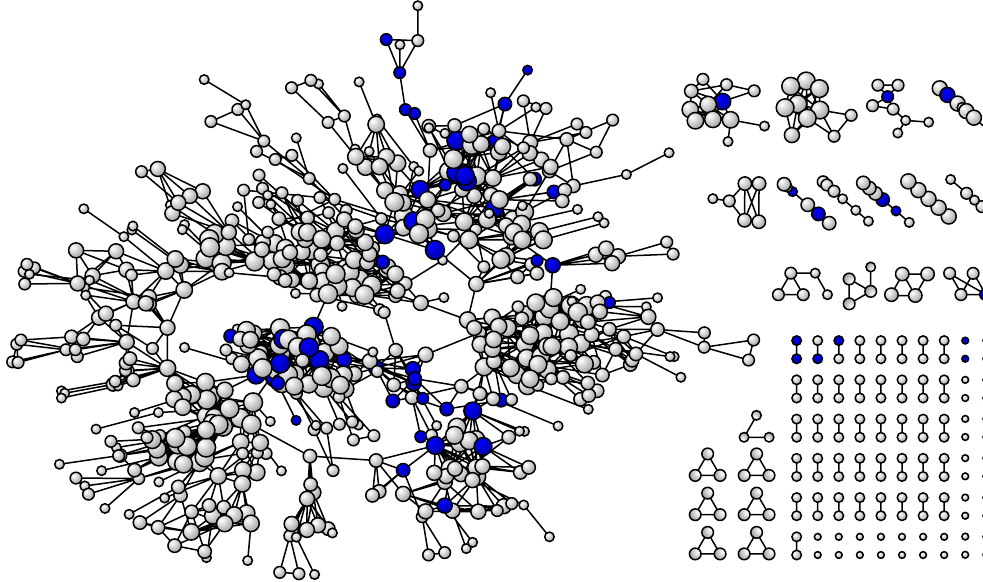
Figure 2. A complete network of 830 individuals in Township K. A circle stands for each individual, and a line for social connection between individuals. Bigger size represents higher score of social network embeddedness. Final samples for this study (n = 64) are colored in